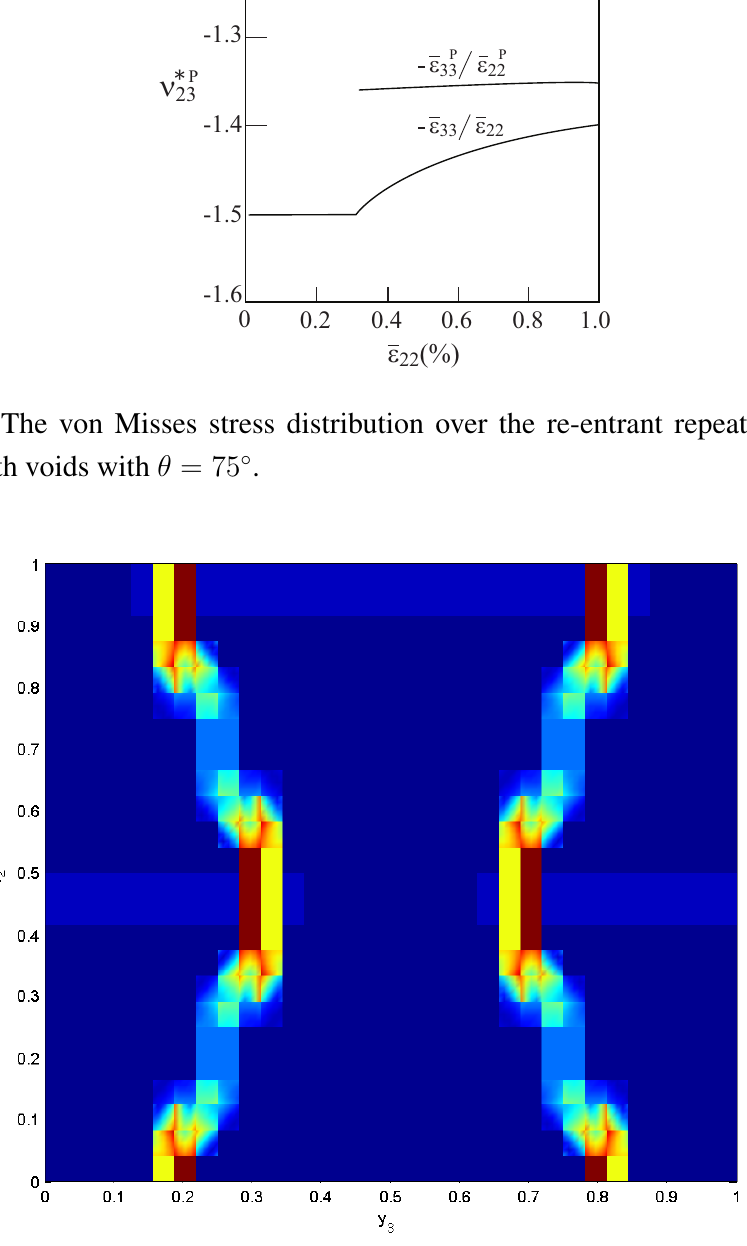
Figure 9. Plastic and apparent Poisson ratio of aluminum with voids in the re-entrant array with θ = 75 ◦ , under uniaxial stress in the y